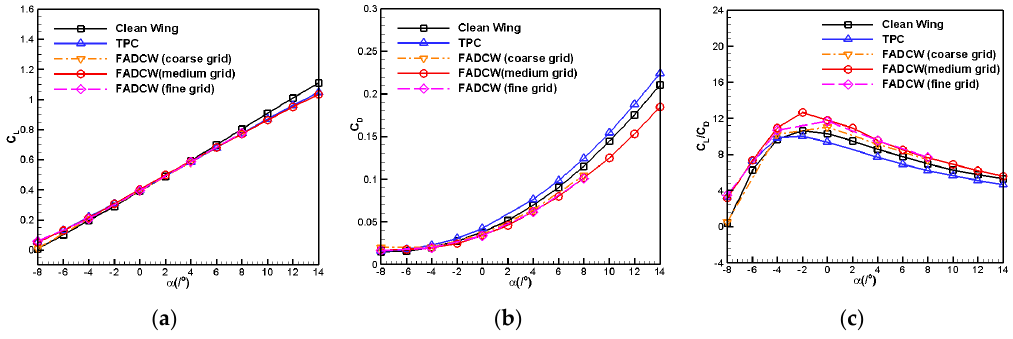
Figure 11. Comparisons of aerodynamic forces for di ff erent configurations ( Ma = 0.1017, Ω = 4400 r/min): ( a ) C L − α , ( b ) C D − α , ( c ) C L / C D − α